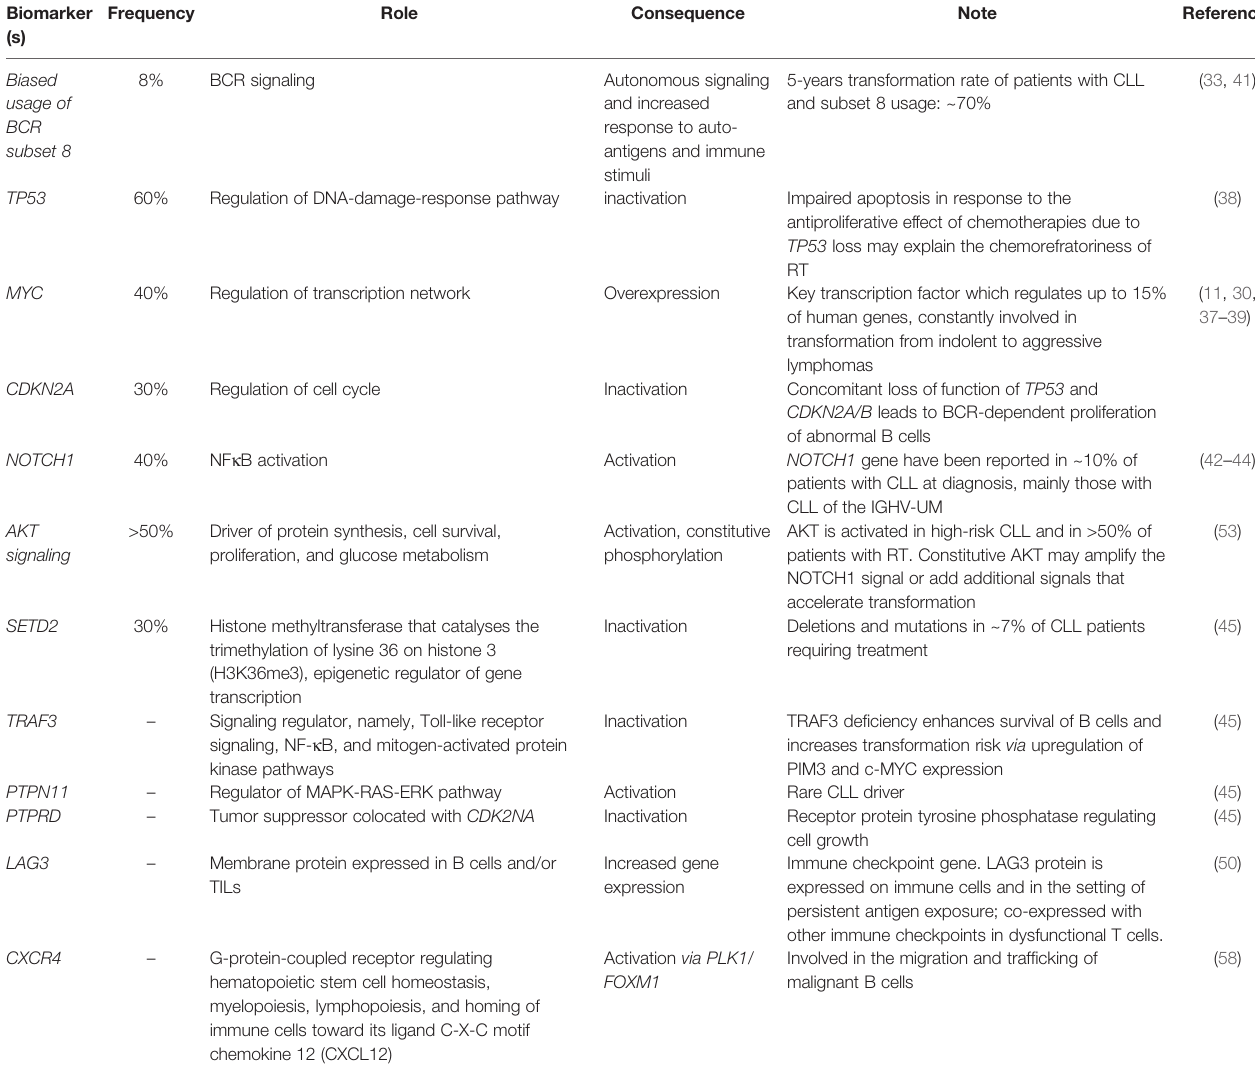
TABLE 1 | Summary of the main biomarkers involved in DLBCL-RT